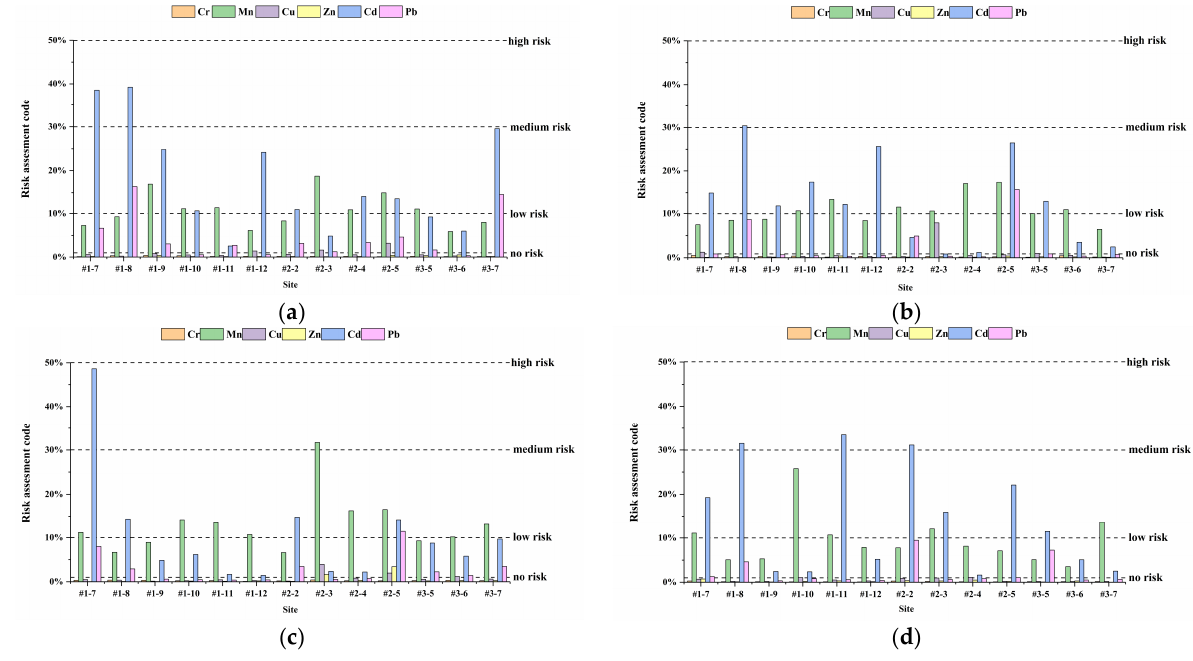
Figure 6. RAC statistics of HMs in soil at different depths in the production area: ( a ) 0–0.5 m; ( b ) 0.5–1 m; ( c ) 1–2 m; ( d ) 2–3